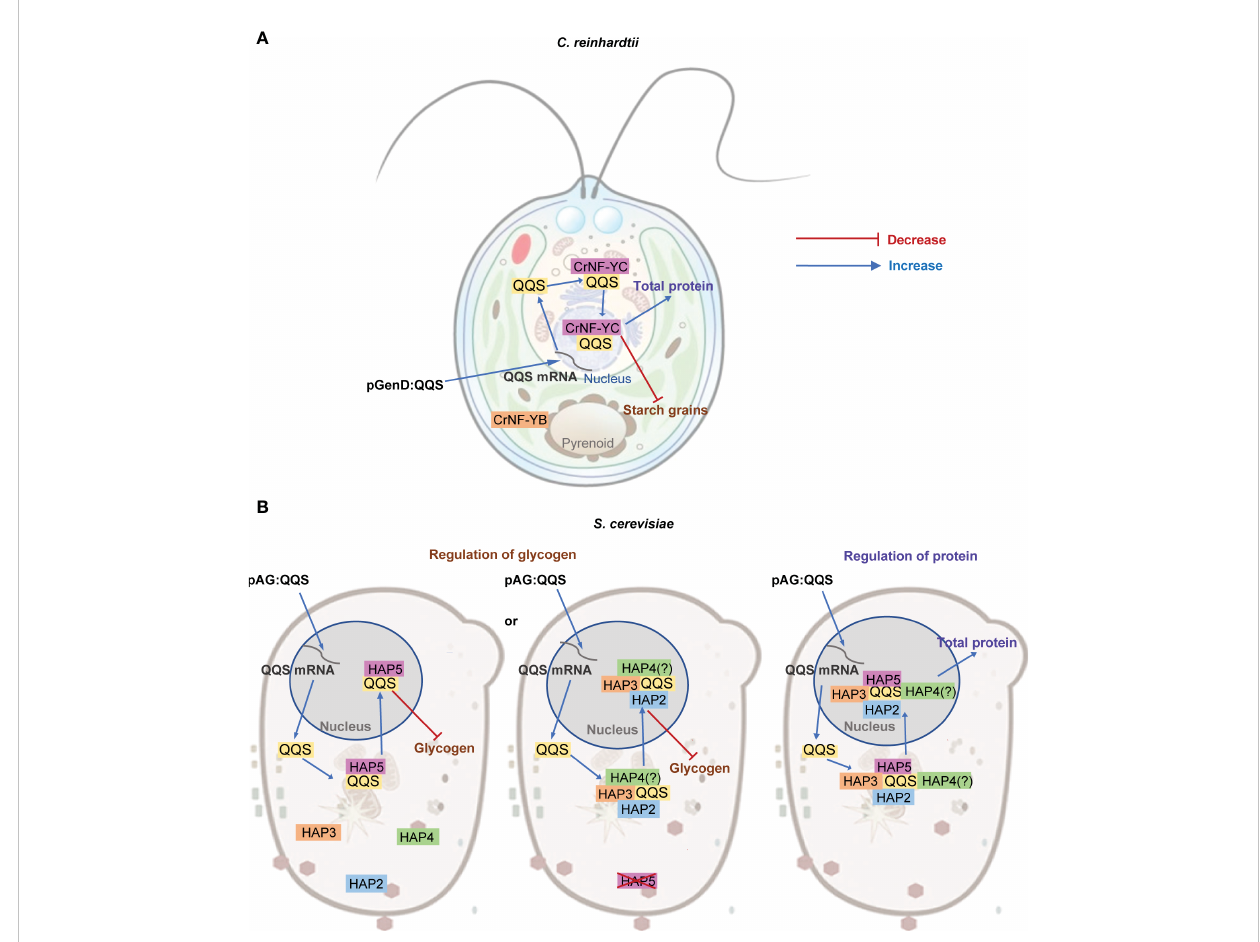
FIGURE 7 Proposed model for the interaction between QQS and NF-Y subunits in single-cell organisms. (A) In C. reinhardtii , regulation of C and N allocation appears to be via the interaction between QQS and the NF-YC subunit that functions in the nucleus, and does not need the NF-YA subunit. (B) In S. cerevisiae , QQS appears to regulate glycogen level via the interaction of QQS with either only HAP5 or with HAP2, HAP3 or HAP4, and affect protein content via the interaction with the HAP complex that requires HAP2, HAP3, HAP4 and